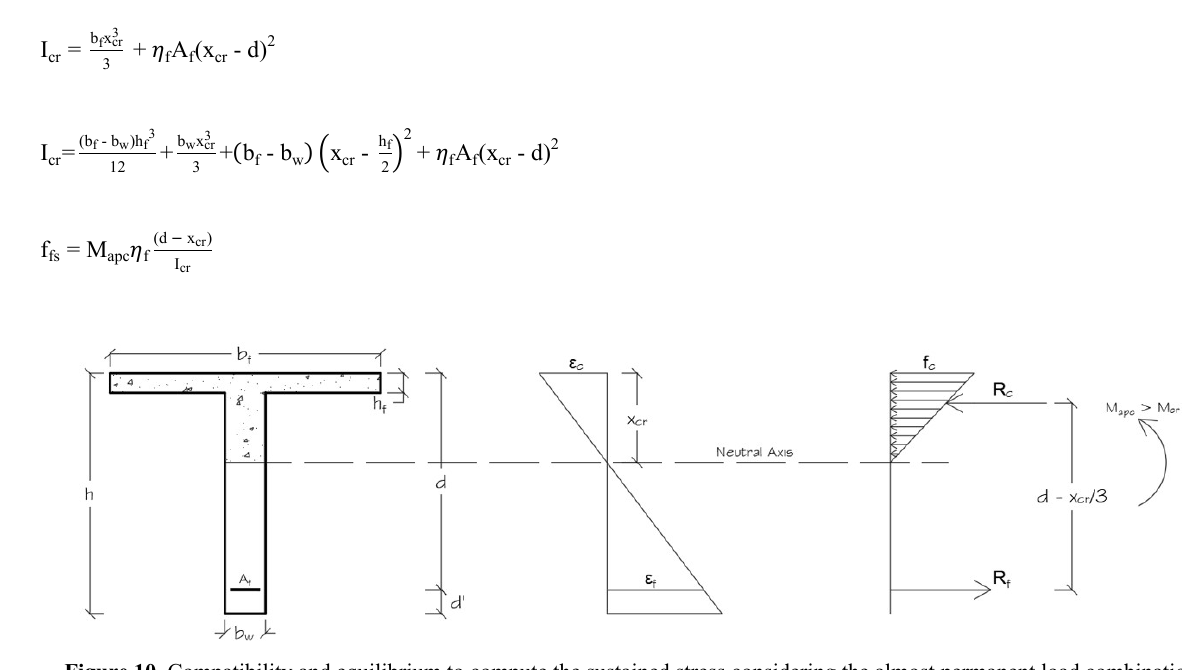
Figure 10. Compatibility and equilibrium to compute the sustained stress considering the almost permanent load combination